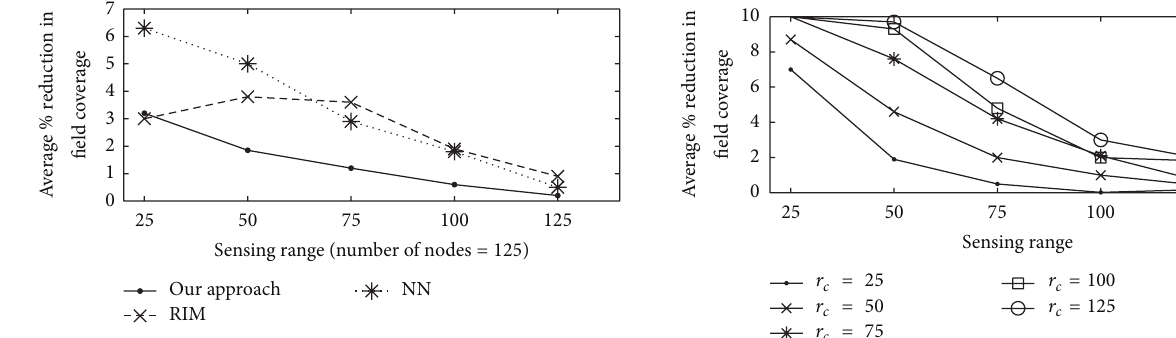
Figure 7: Reduction in field coverage versus sensing range (m) for 25 to 125 nodes.